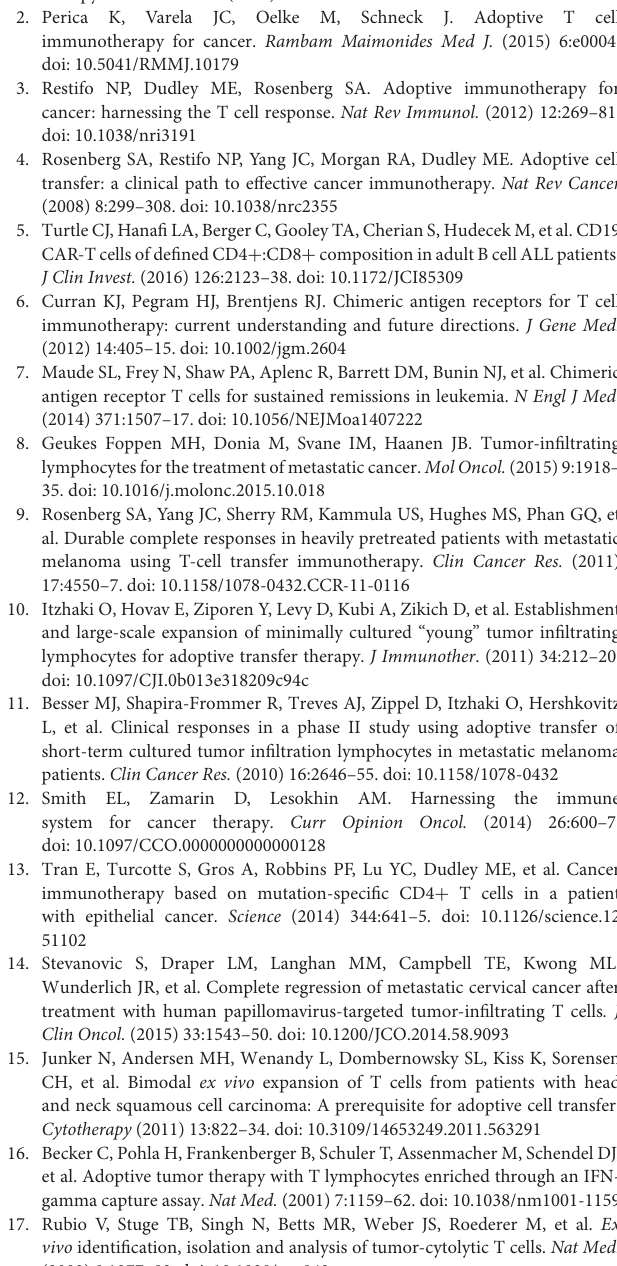
Figure S4 | Immunophenotype and suppression assays of non-doublet T cells. (A) The regulatory phenotype was evaluated in non-doublet T cells that express CD25. Dot plots show the expression of CD4, CD25, FoxP3, and CD127 on non-doublet T cells CD25 + (CD3 + PKH–CD25 + ). Data show one representative experiment of six independent experiments. (B) Proliferation, monitored by PKH-67 dilution of control or α CD3/ α CD28 stimulated responder T cells,